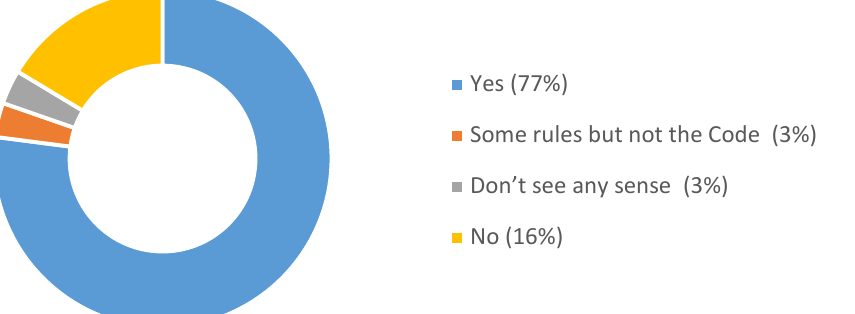
Source: Calculated by the authors on the basis of the conducted research.